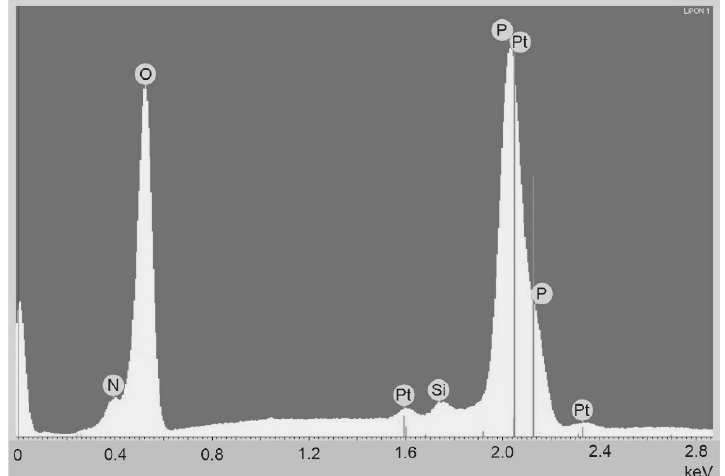
Figure 2. EDA (energy dispersive analysis) spectrum of solid LiPON electrolyte with platinum electrodes. Thin lines are platinum markers, where the marker height is proportional to the line intensity. The Si–K α peak is due to the fluorescence of the silicon atom in the detector.